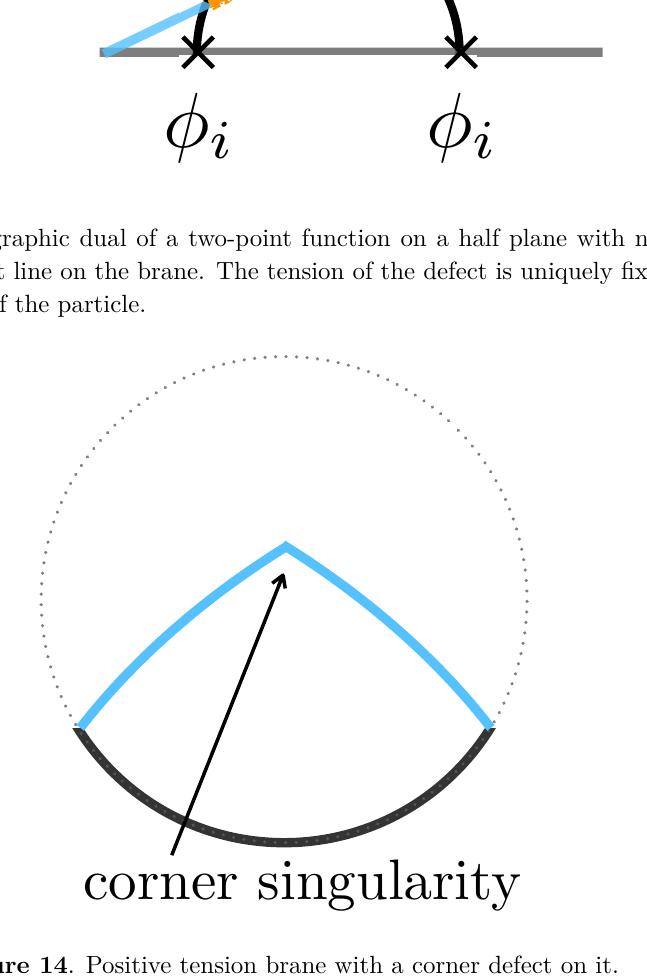
Figure 14 . Positive tension brane with a corner defect on